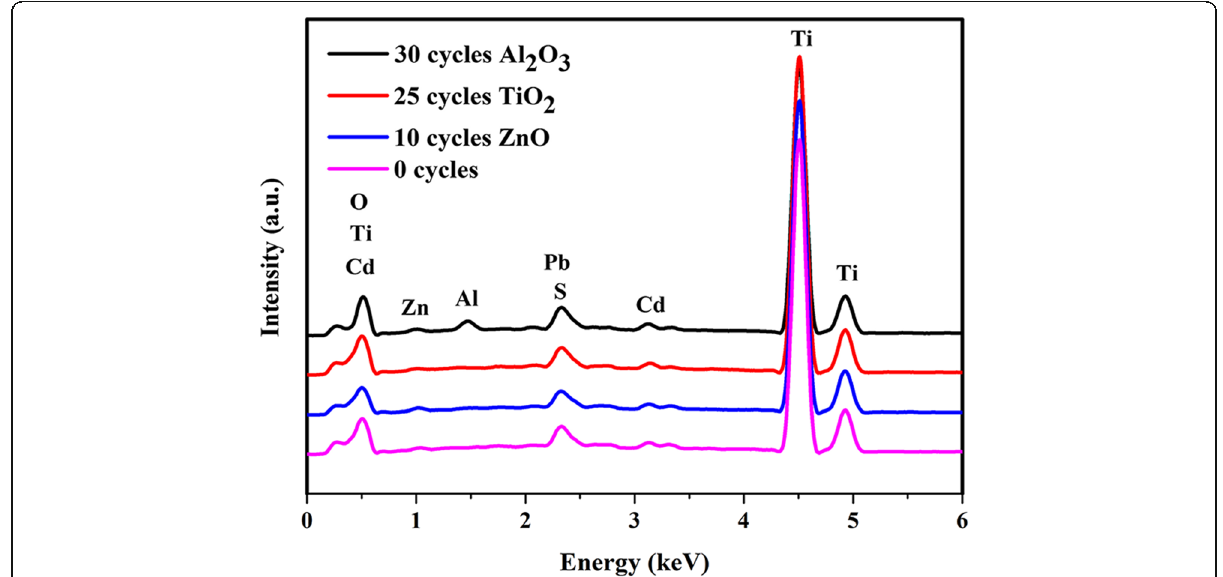
Fig. 4 EDS results of the TNTAs/QDs, TNTAs/QDs/10 cycles ZnO, TNTAs/QDs/25 cycles TiO 2 , and TNTAs/QDs/30 cycles Al 2 O 3